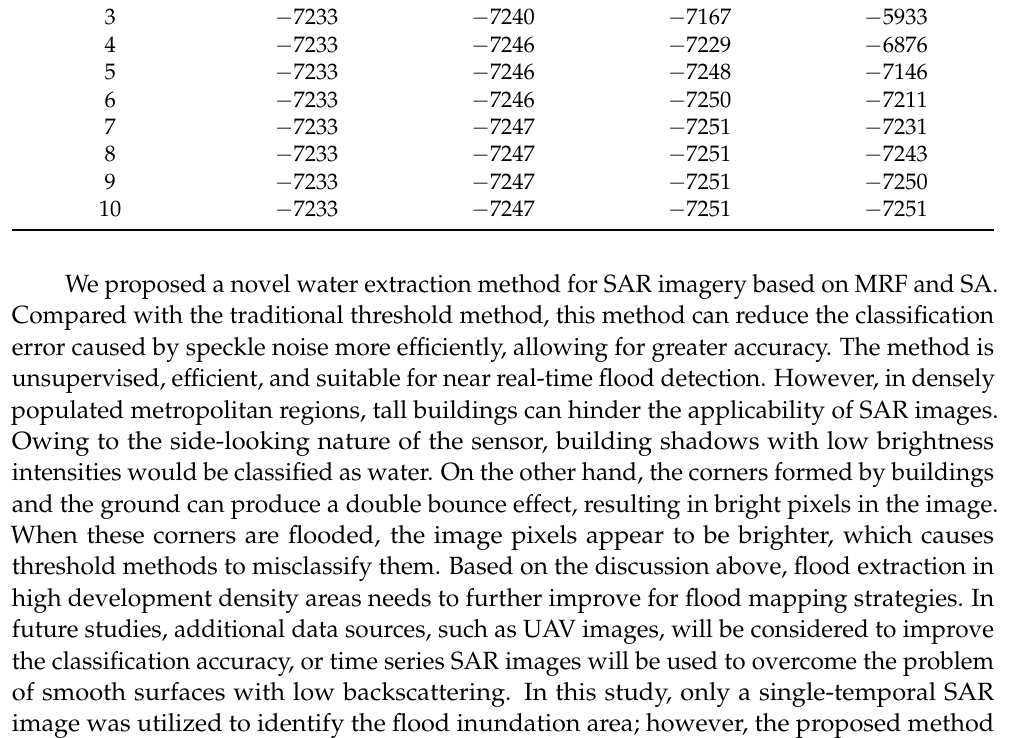
Table 5. Global energy change in the HV polarization of Boluokeng during the iterative operation. k s =